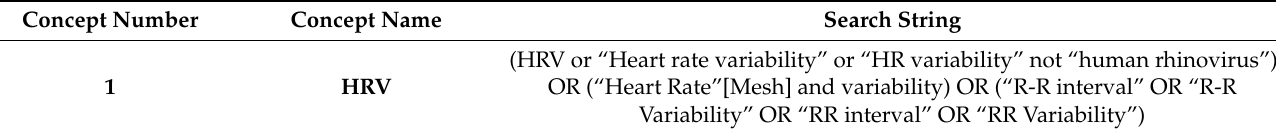
Table A1. HRV Search